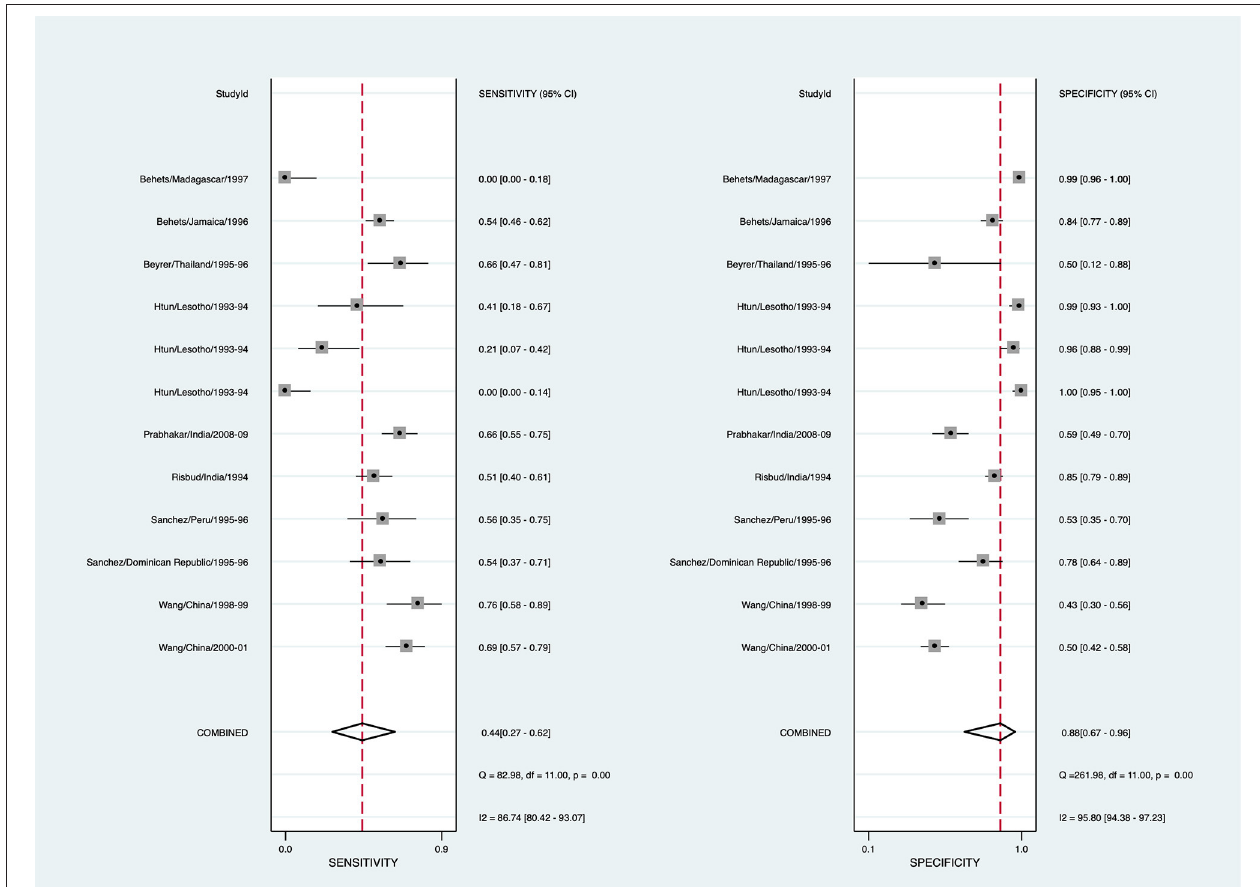
FIGURE 2 | Forest plot of the sensitivity and specificity of clinical diagnosis to detect herpes simplex virus in genital ulcer disease.